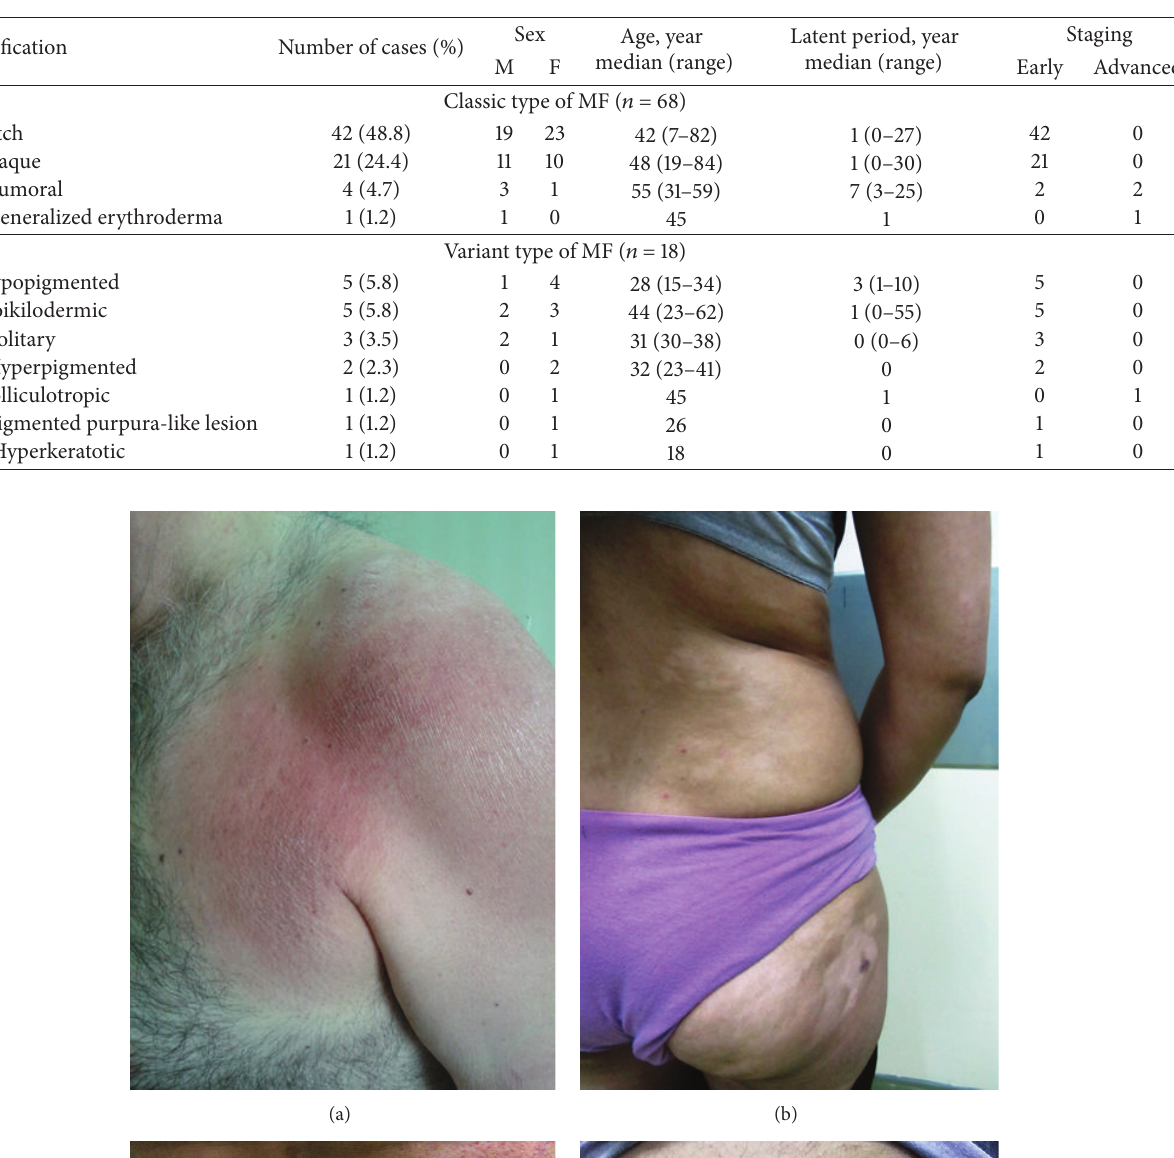
Table 2: Clinical characteristics of patients based on the different clinical variants of mycosis fungoides.